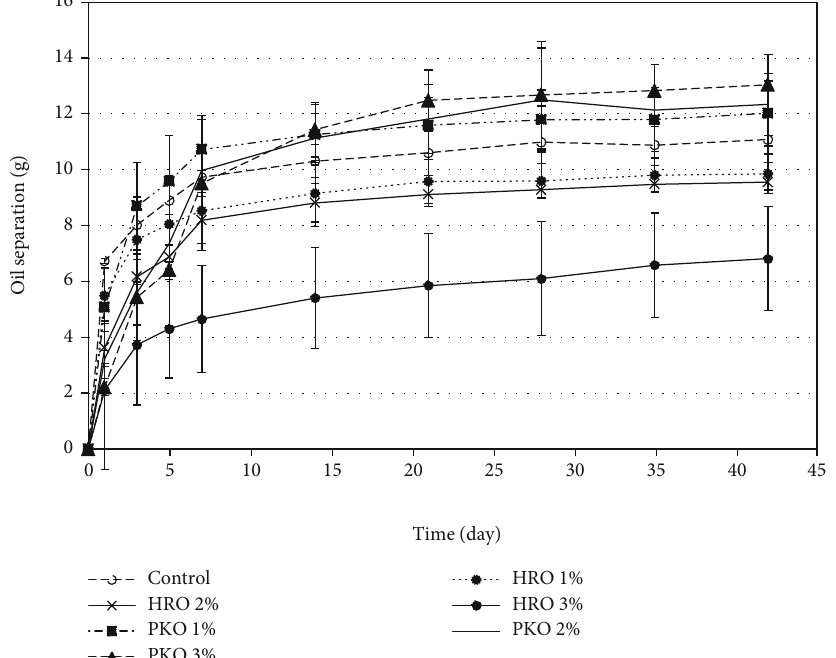
Figure 6: The e ffi cacies of HRO and PKO on the oil separation in the seed